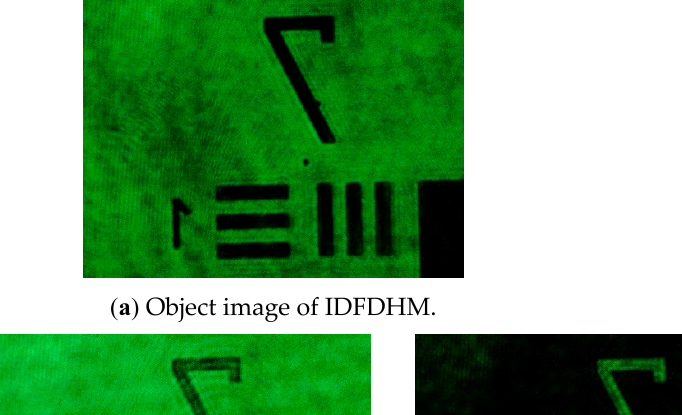
( a ) Object image of IDFDHM. ( b ) Object image of control set.